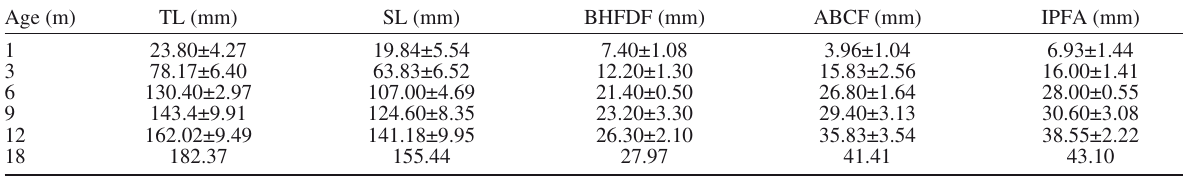
Table 1. – Summary of all measurements taken during the sardine growth experiment. Age (m): age in months; TL (mm): total length; SL (mm): standard length; BHFDF (mm): back of head to first dorsal fin ray; ABCF (mm): anus to base of caudal fin; IPFA (mm): insertion of pelvic fin to